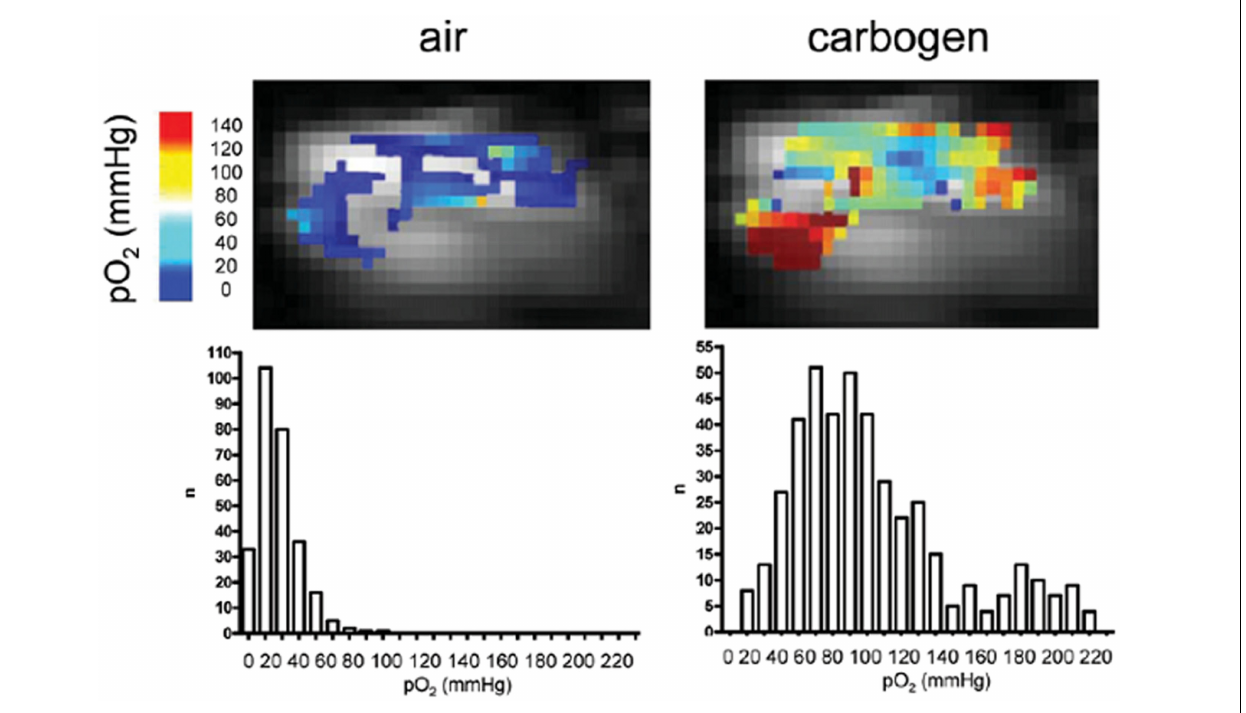
FIGURE 4 | 19F-MRI oxygen mapping. Shown are typical oxygen maps obtained using 19F-MRI with hexafluorobenzene as the oxygen sensor in an experimental tumor under air or carbogen (95% O 2 , 5% CO 2 ) breathing